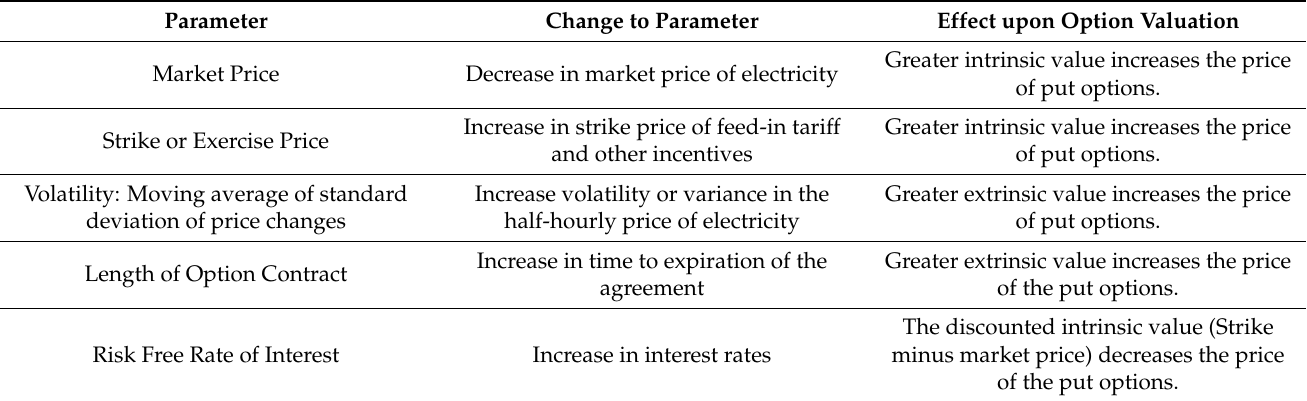
Table 1. Put option parameters (source: adapted by authors from